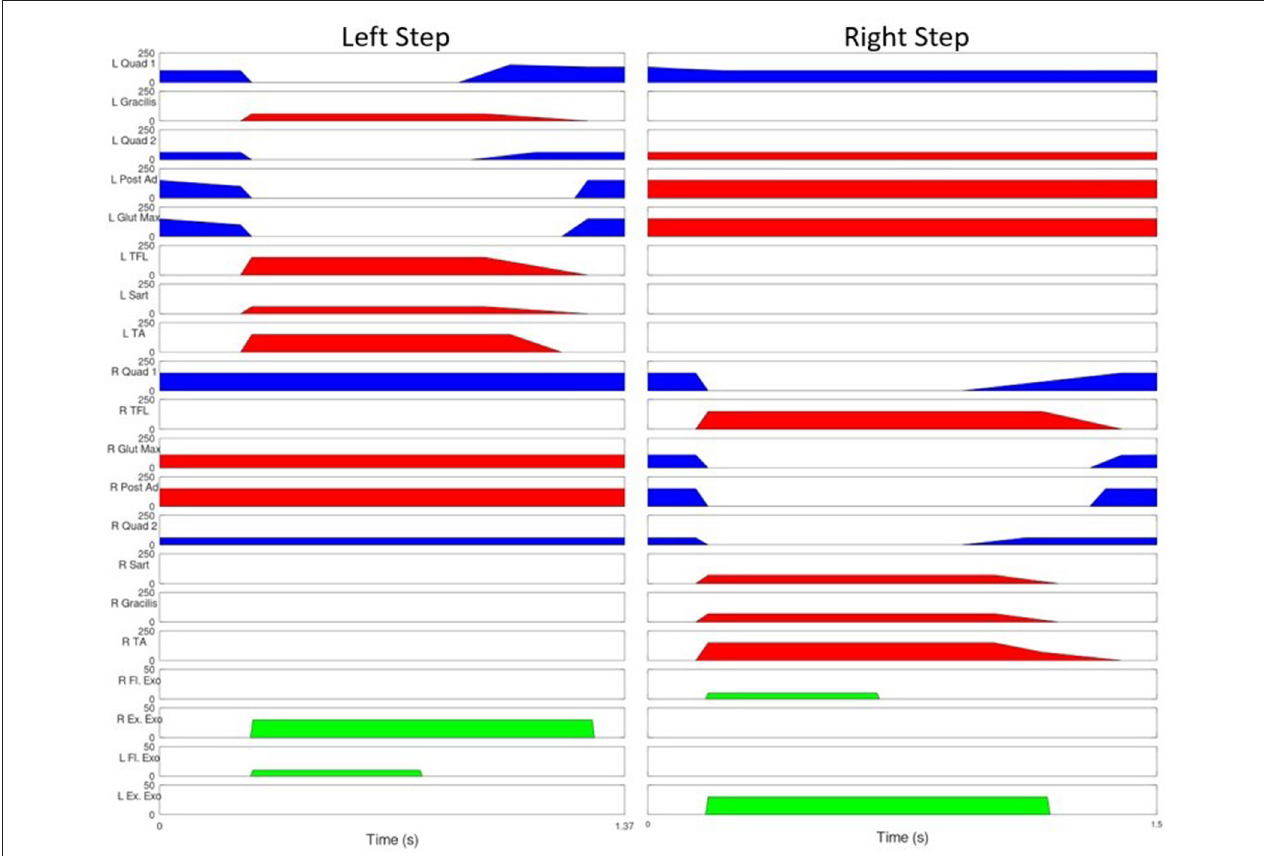
FIGURE 7 | Stimulation Pattern for user with SCI. Blue represents 30 ms between pulses, red indicates 60, green indicates joint torque provided by the exoskeleton joints. The vertical lines represent the beginning of swing phase.